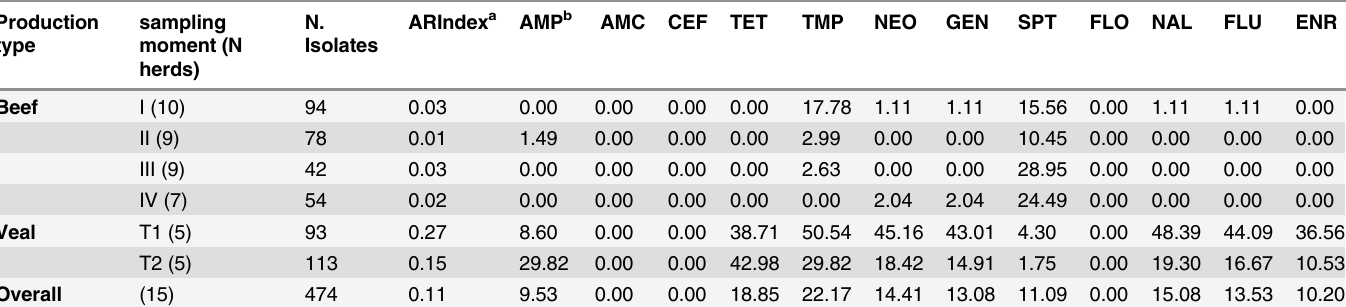
Table 6. Overview of resistance percentages of Pasteurellaceae during the consecutive sampling periods on the different production